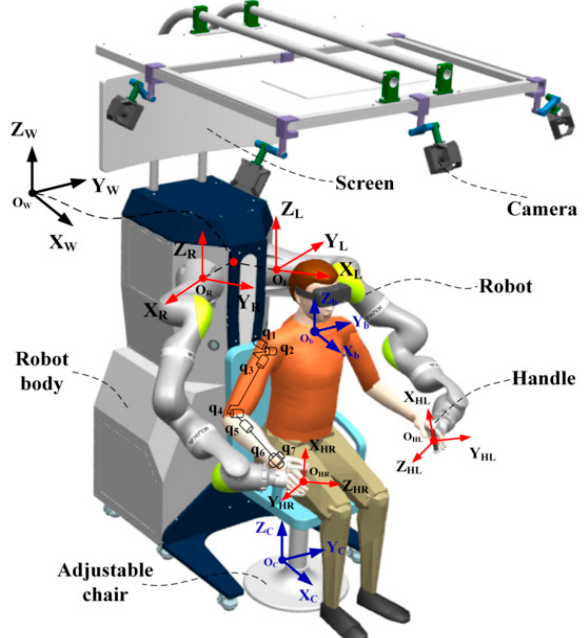
Figure 1. Three-dimension model of the end-effector upper limb rehabilitation robot (EULRR) designed in SolidWork.